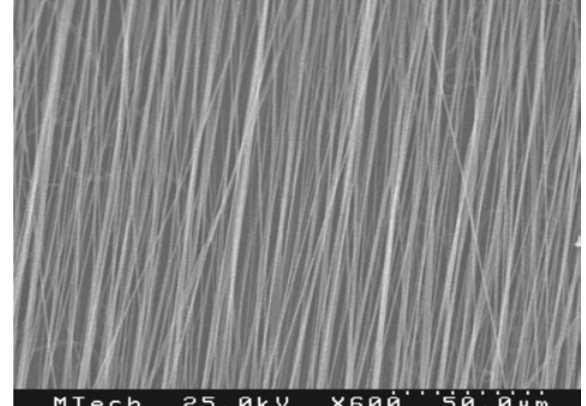
Figure 6: Scanning electron micrograph of polycaprolactone nanofibers produced using solution-ES. Fibers were deposited between parallel electrodes to initiate alignment and have an average diameter of 600–800